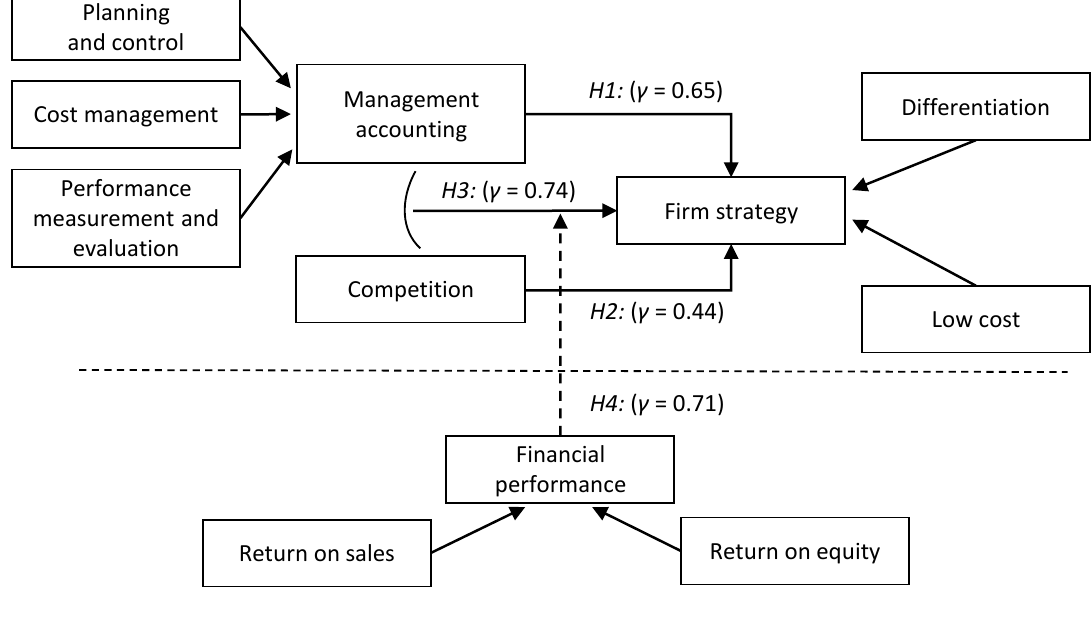
Figure 2. Tested structural model